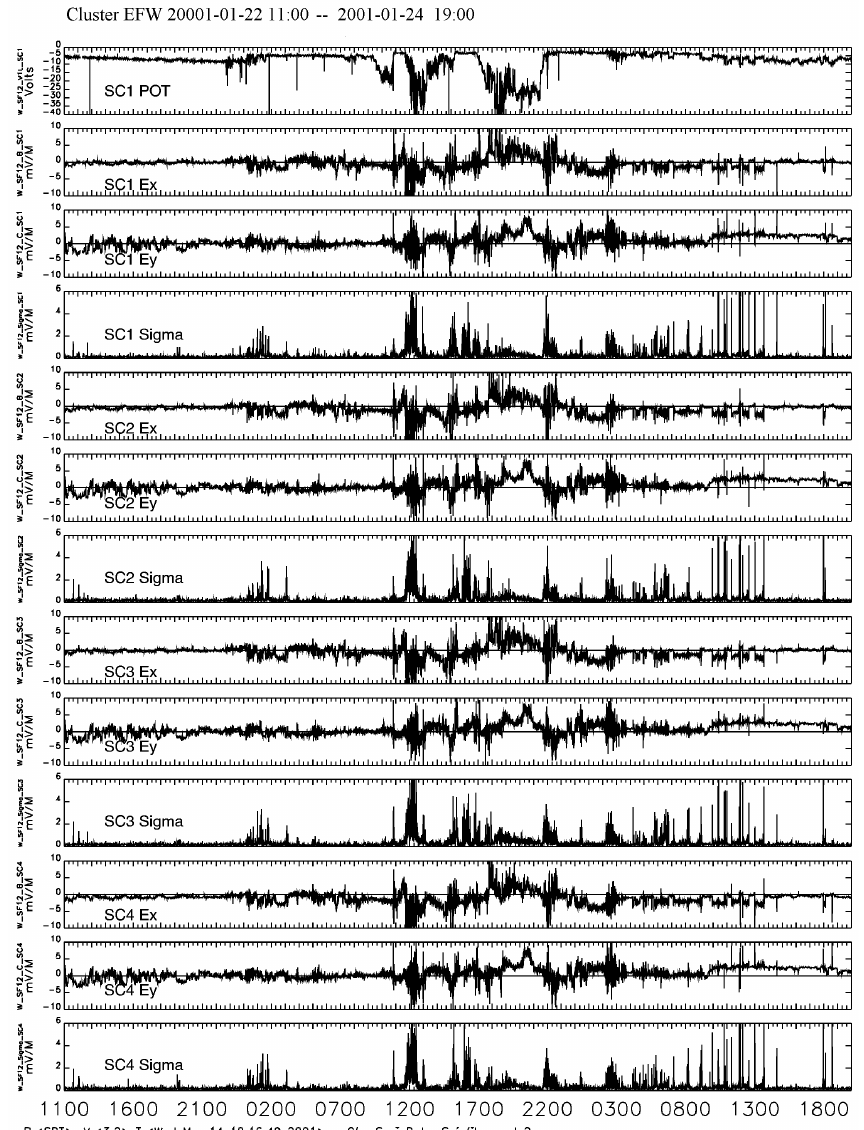
Fig. 1. A full orbit (57 hours) of EFW data from 22 January, 11:00 UT to 24 January, 19:00 UT. “Pot” is the probe-to-spacecraft voltage, while the other parameters are spin-period averages. E X and E Y are the electric field components in the directions of the projections of the GSE X and Y axes in the spin-plane, deviating a few degrees from the true GSE XY plane, while “Sigma” is the RMS deviation of the spin-fits, thus providing information about variations above the spin frequency. The figure shows raw data from onboard processing and a few glitches can be seen in the